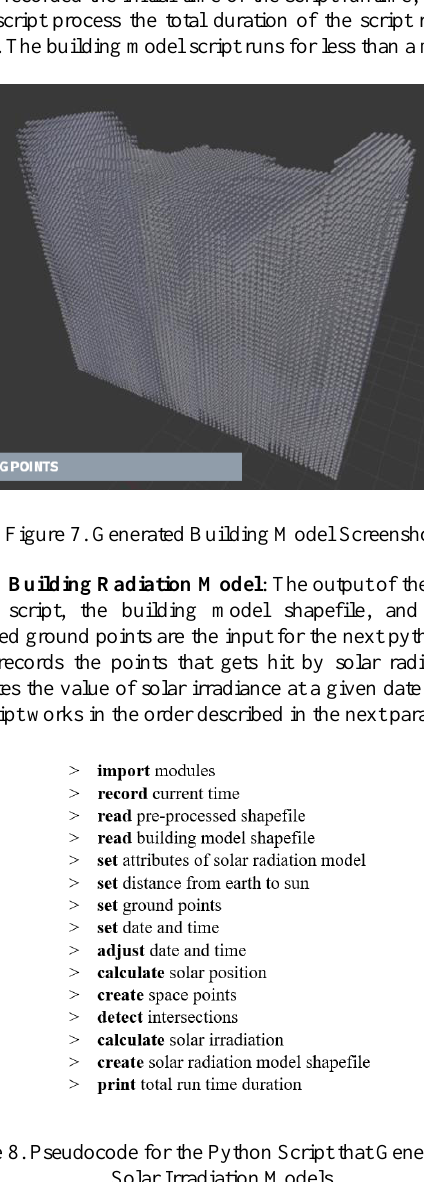
Figure 6. Pseudocode for the Python Script that Generates the Building Model